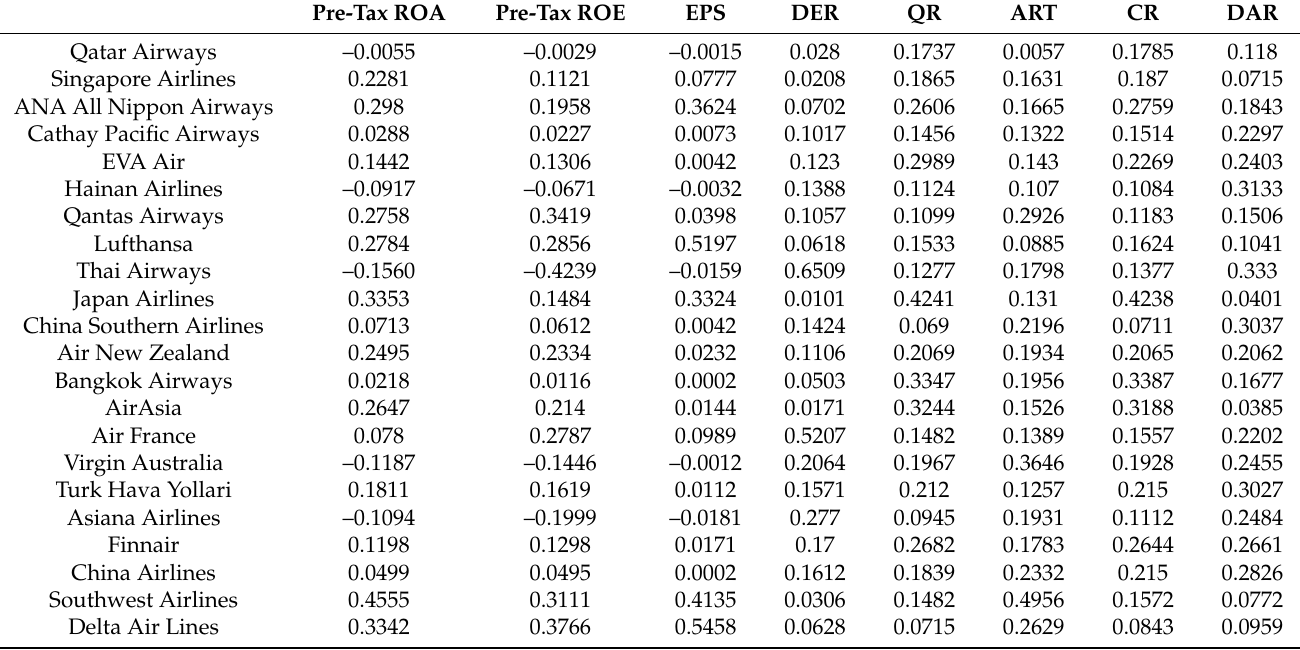
Table 4. Normalized data matrix (for